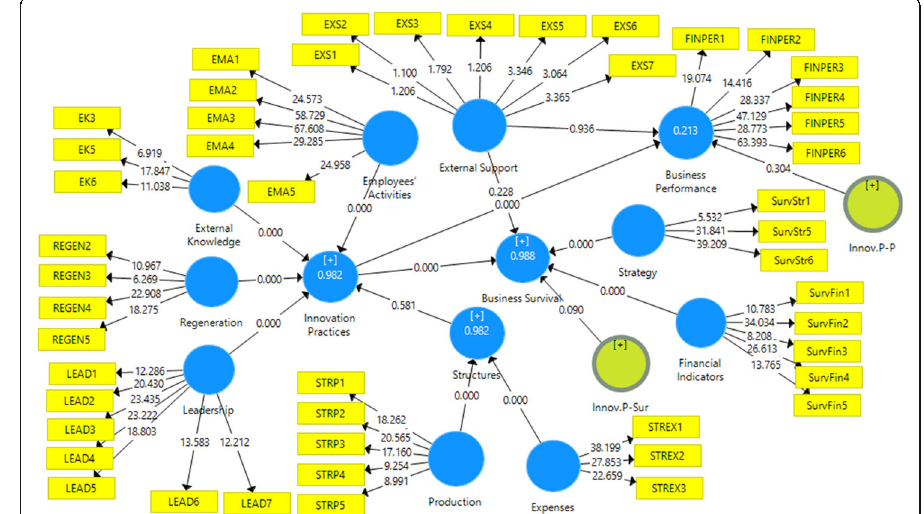
Fig. 2 PLS-SEM model with moderating